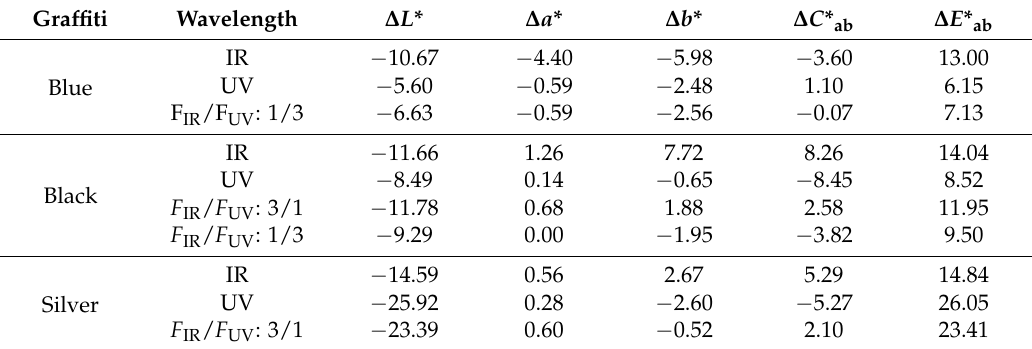
Table 3. Colorimetric differences ( ∆ L *, ∆ a *, ∆ b *, ∆ C * ab ) and global color changes ( ∆ E * ab ) of the surfaces irradiated with the selected conditions. The differences were computed considering the unpainted granite as reference. Detailed info on fluence values and pulses for each irradiation condition can be found in Table